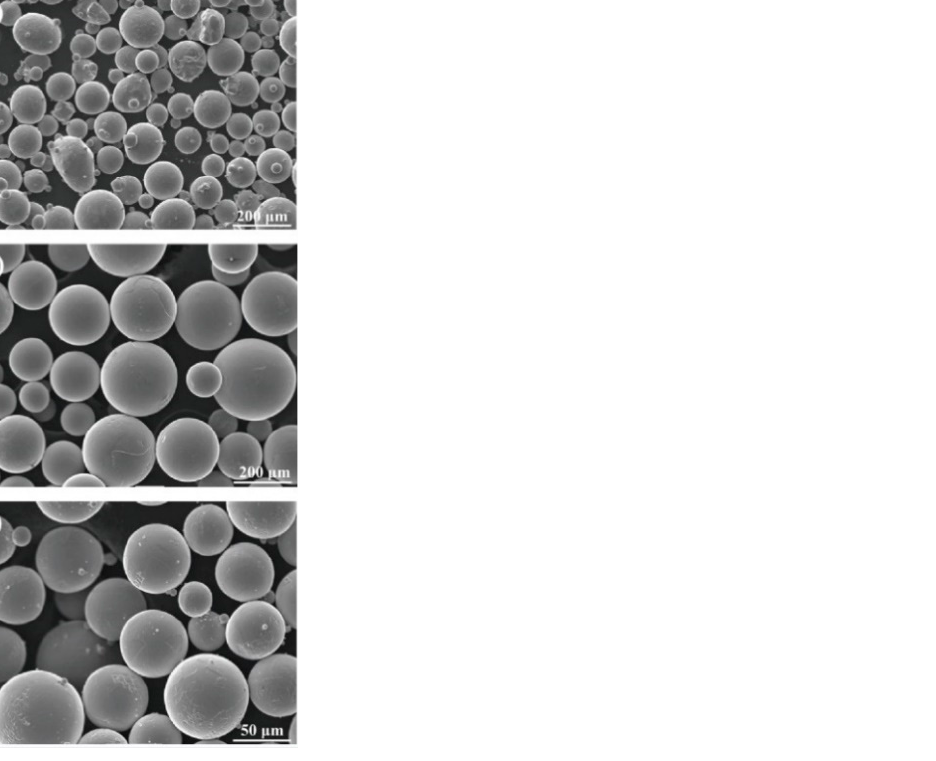
Figure 32. Surface micrographs of Ti-6Al-4V powders by different methods: ( a ) GA; ( b ) PREP; ( c ) PA [81].